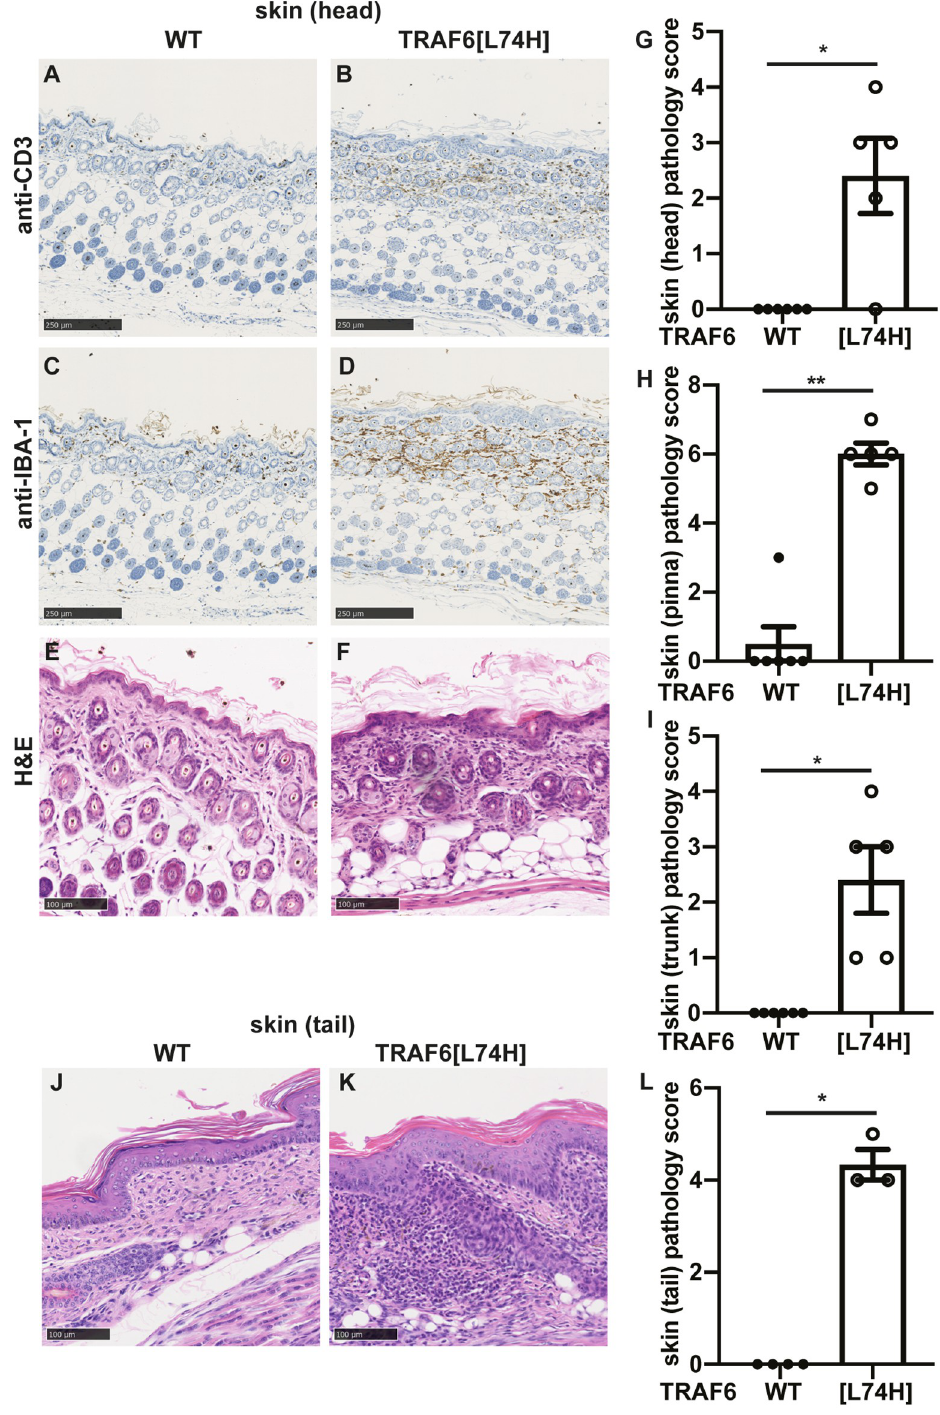
Fig 4. Severe skin inflammation seen in TRAF6[L74H] mice. (A, B) Representative images showing skin sections from WT (A) and TRAF6[L74H] mice processed for immunohistochemistry and stained using anti-CD3 antibody. (C, D) As in A, B except that anti-IBA-1 antibody was used. (E, F) As in A, B except that skin sections from WT (A) and TRAF6[L74H] were stained with haematoxylin and eosin (H&E). (G-I) Bar graphs showing cumulative skin inflammation scores from head (G), pinna (the visible portion of the outer ear) (H) and trunk (I). (J, K) As in E, F, except the representative tail sections are shown. (L) As in G, except that the cumulative pathology score of the tail is